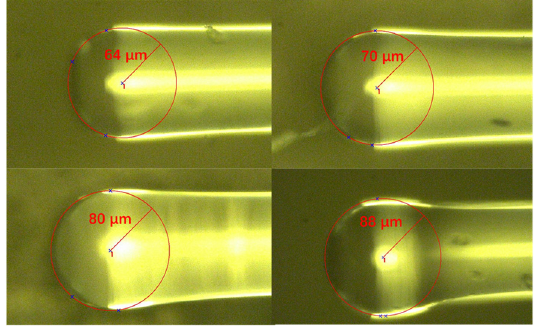
Figure 10. Spherical end faces with different radii.